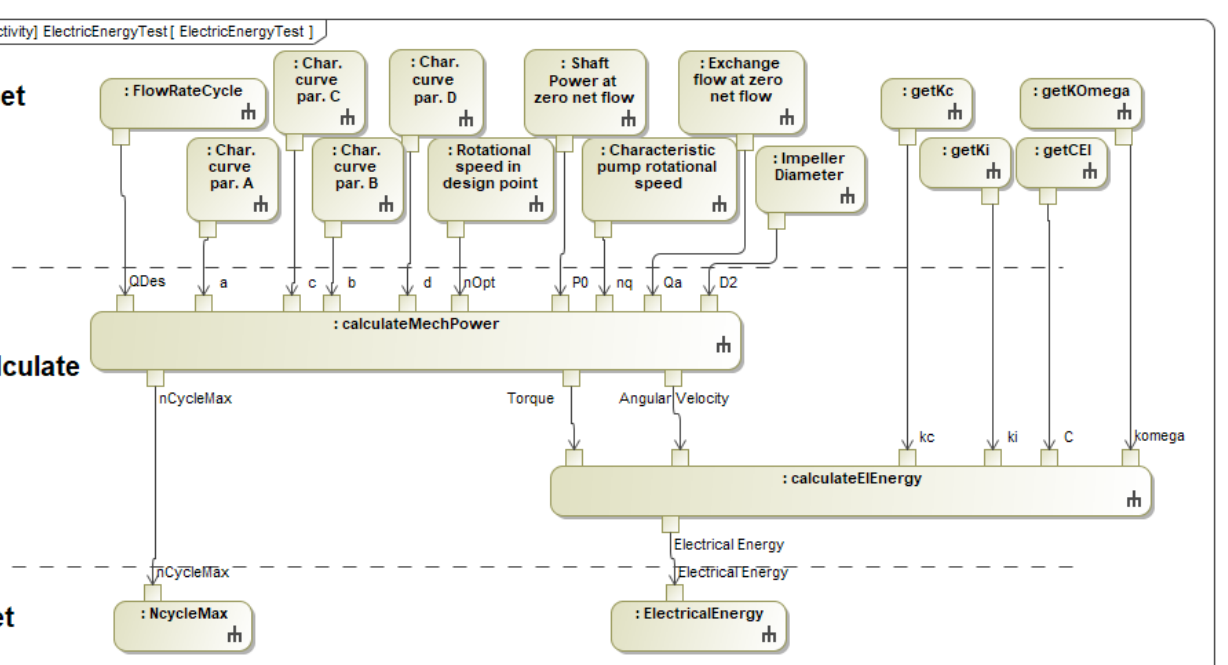
Figure 8. Manual iteration using design and test workflows. First, in Figure 8, the system is specified in the MBSE system model. The system specification includes the collection and definition of requirements and the derivation of a suitable functional and solution architecture. From this, simulation models are derived and linked in design and test workflows. The design workflow uses these models and other calculations (norms, standards, and guidelines) to determine the parameters of the solution architecture. In the test workflow, parameter values are calculated and checked for requirement satisfaction. If requirements are not met, the design variables are changed, and the design and test workflows are executed again. If the requirements are met, the design can be approved and detailed. There may arise the case that no technical variant can fulfill the requirements. Then requirements can be relaxed, or they can be returned to a previous development phase to adapt the system architecture. These two cases are not considered in this paper. In the case of the electric coolant pump, there are any number of technical variants that meet the exemplary requirements (Figure 6). However, during the design and test